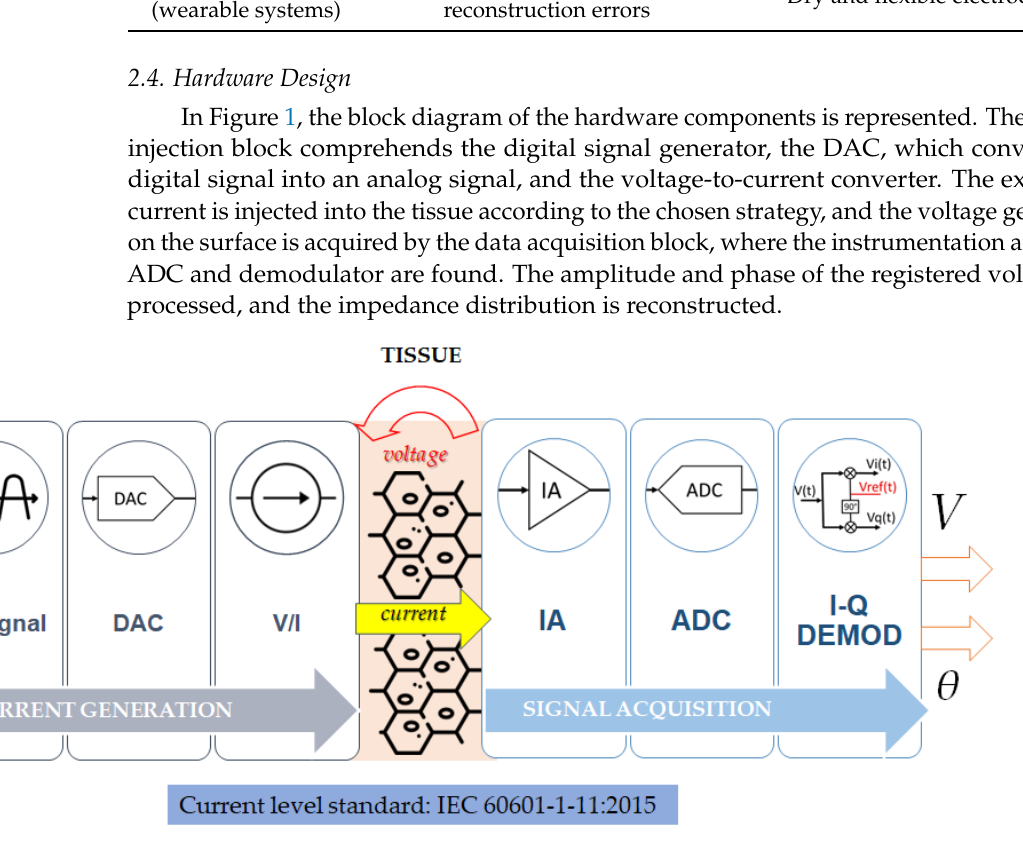
Table 2. Issues, challenges and innovative solutions found in the choice and design of electrodes.